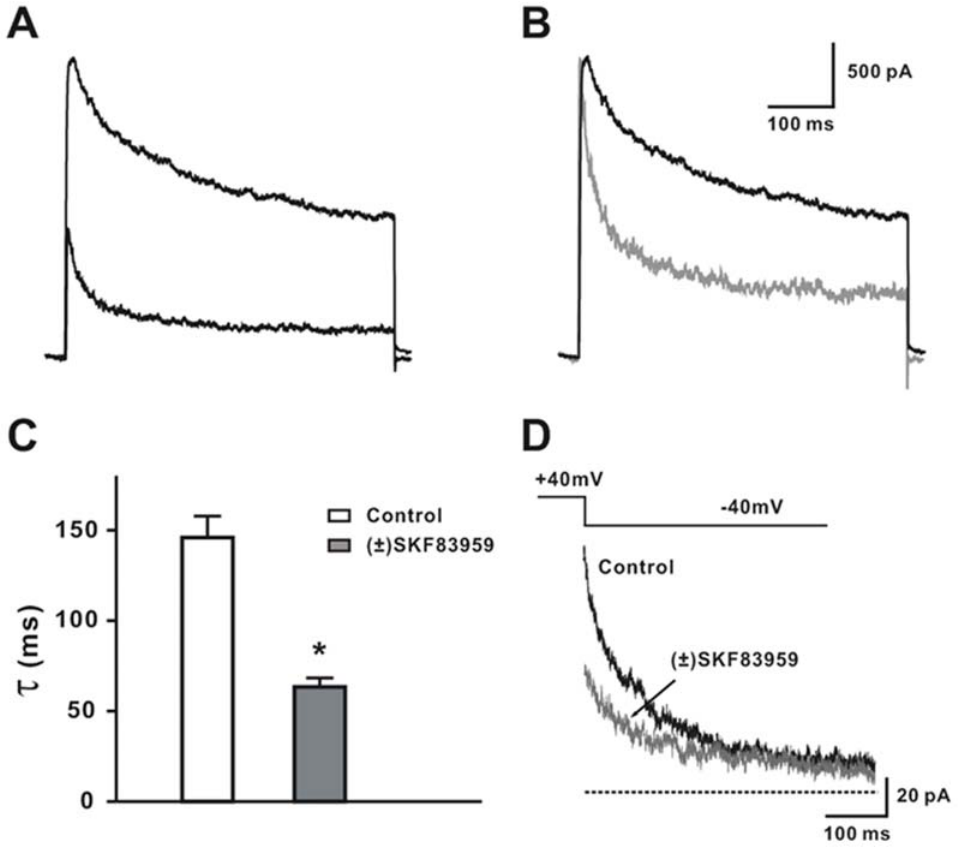
Figure 6. Effects of ( 6 ) SKF83959 on the decay of the delayed rectifier K + current in rat hippocampal neurons. (A) Superimposed traces of the delayed rectifier K + current ( I K ) in a representative neuron prior to and during superfusion with ( 6 ) SKF83959 (100 m M). (B) The trace with ( 6 ) SKF83959 in (A) is scaled up. (C) Decay time constants of I K prior to and during superfusion with ( 6 ) SKF83959 (100 m M). n=7, * P , 0.01 versus the control. (D) Tail current traces evoked at 2 40 mV after a 500-ms depolarizing steps to + 40 mV prior to and during superfusion with ( 6 ) SKF83959 (100 m M). Similar results were obtained in 3 neurons.